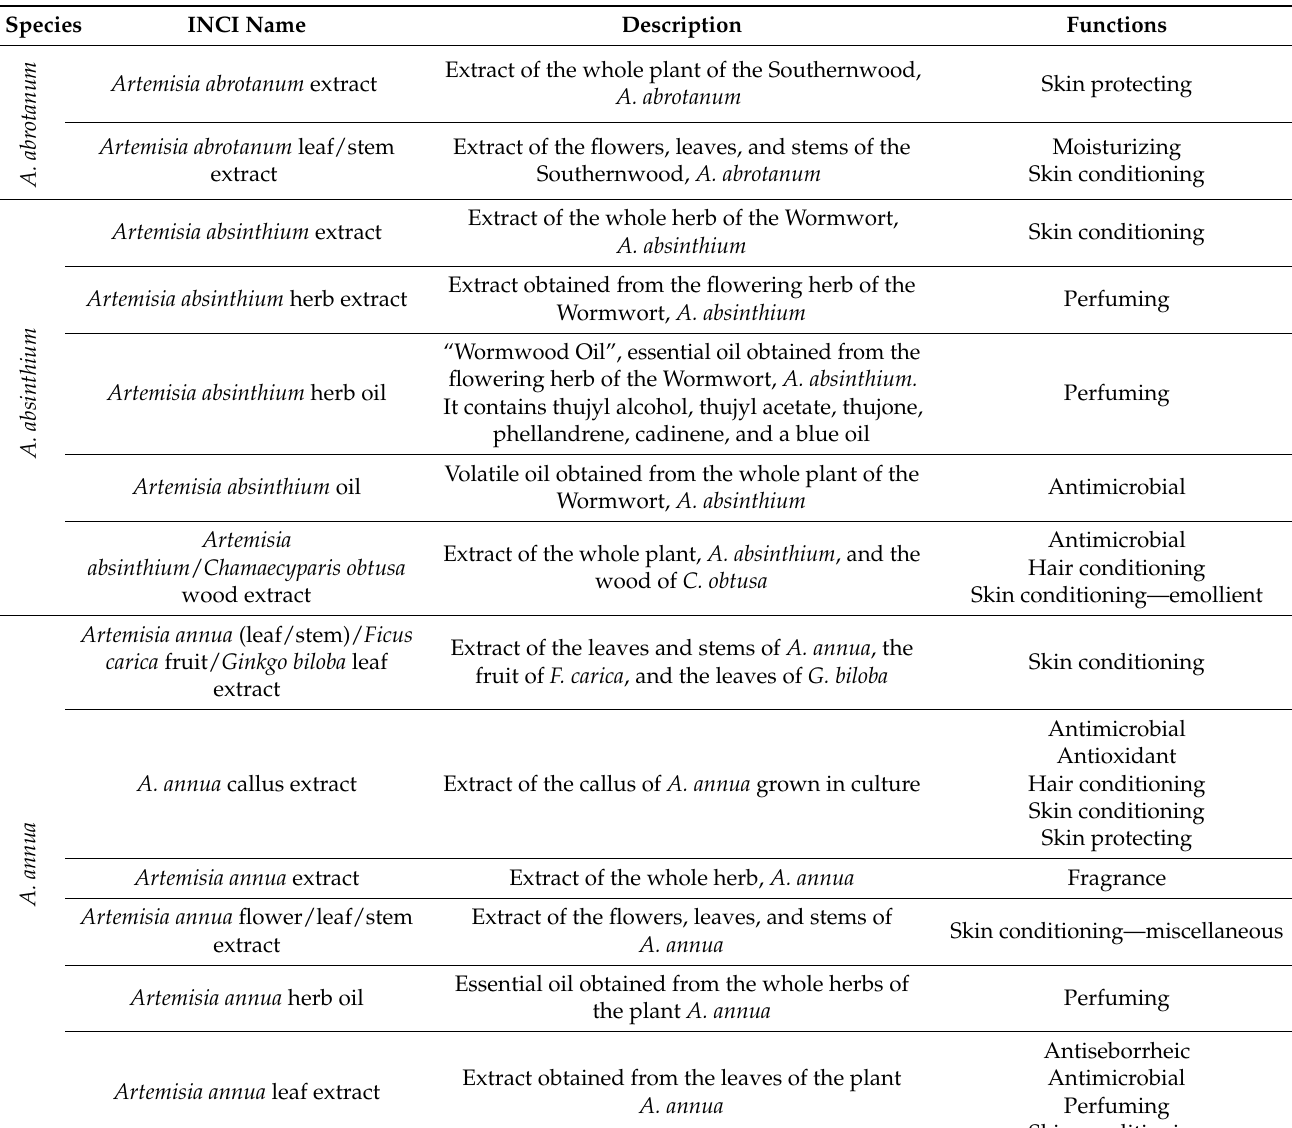
Table 6. Possible applications of Artemisia species in cosmetology as recommended by the CosIng database